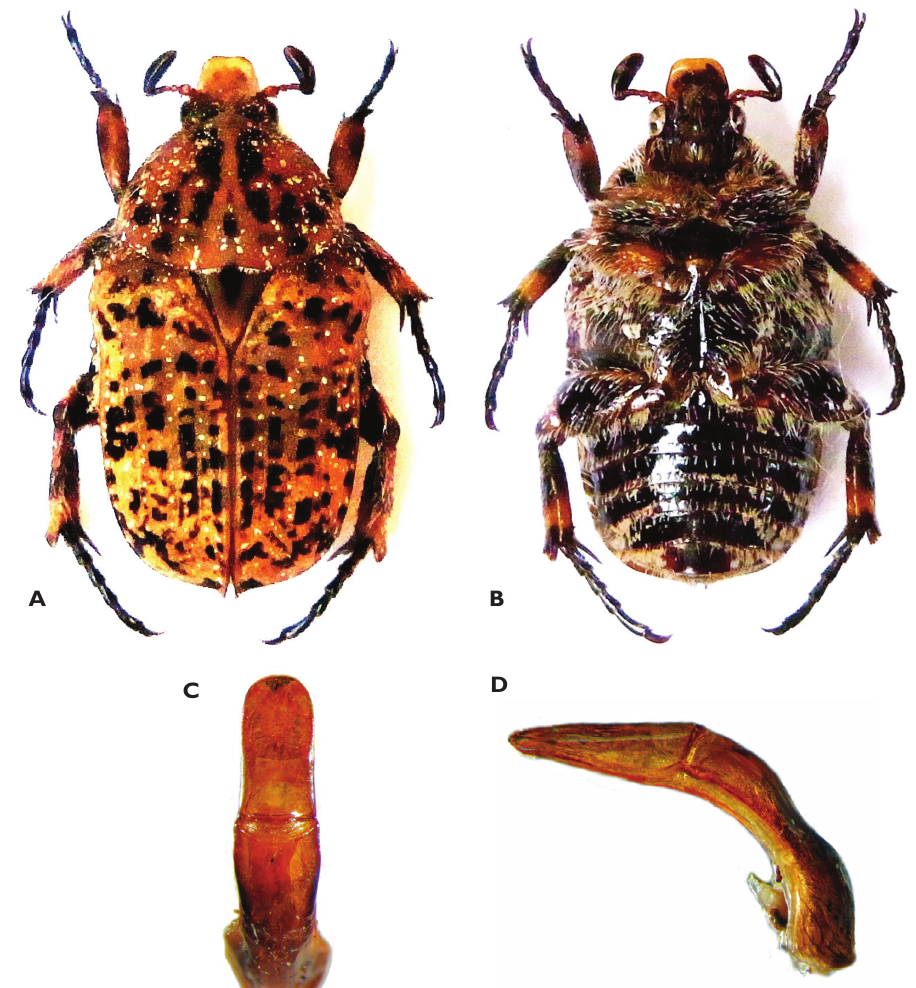
Figure 12. Atrichelaphinis ( Eugeaphinis ) bomboesbergica sp. n. , holotype male (ISAM). A Dorsal view B ventral view C parameres in dorsal view D parameres in lateral